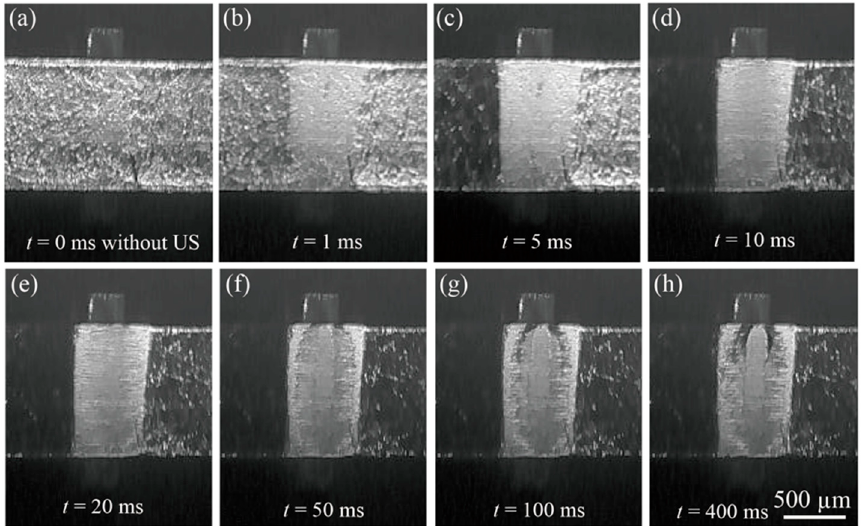
Figure 9. In-situ observation results (video captures) of the bonding interface between Al ribbon and silica substrate obtained at F rate = 10 3 fps. The bonding condition was F b = 7 N and P u = 3 W. Simultaneous measurement result of ultrasonic vibration amplitude is shown in Figure 3 (a–2): ( a ) t = 0 ms without ultrasonic vibration (US); ( b ) t = 1 ms immediately after introducing US; ( c ) Island streaks began to appear at t = 5 ms; ( d ) t = 10 ms; ( e ) t = 20 ms; ( f ) Central belt zone began to be observed at t = 50 ms; ( g ) t = 100 ms; ( h ) t = 400